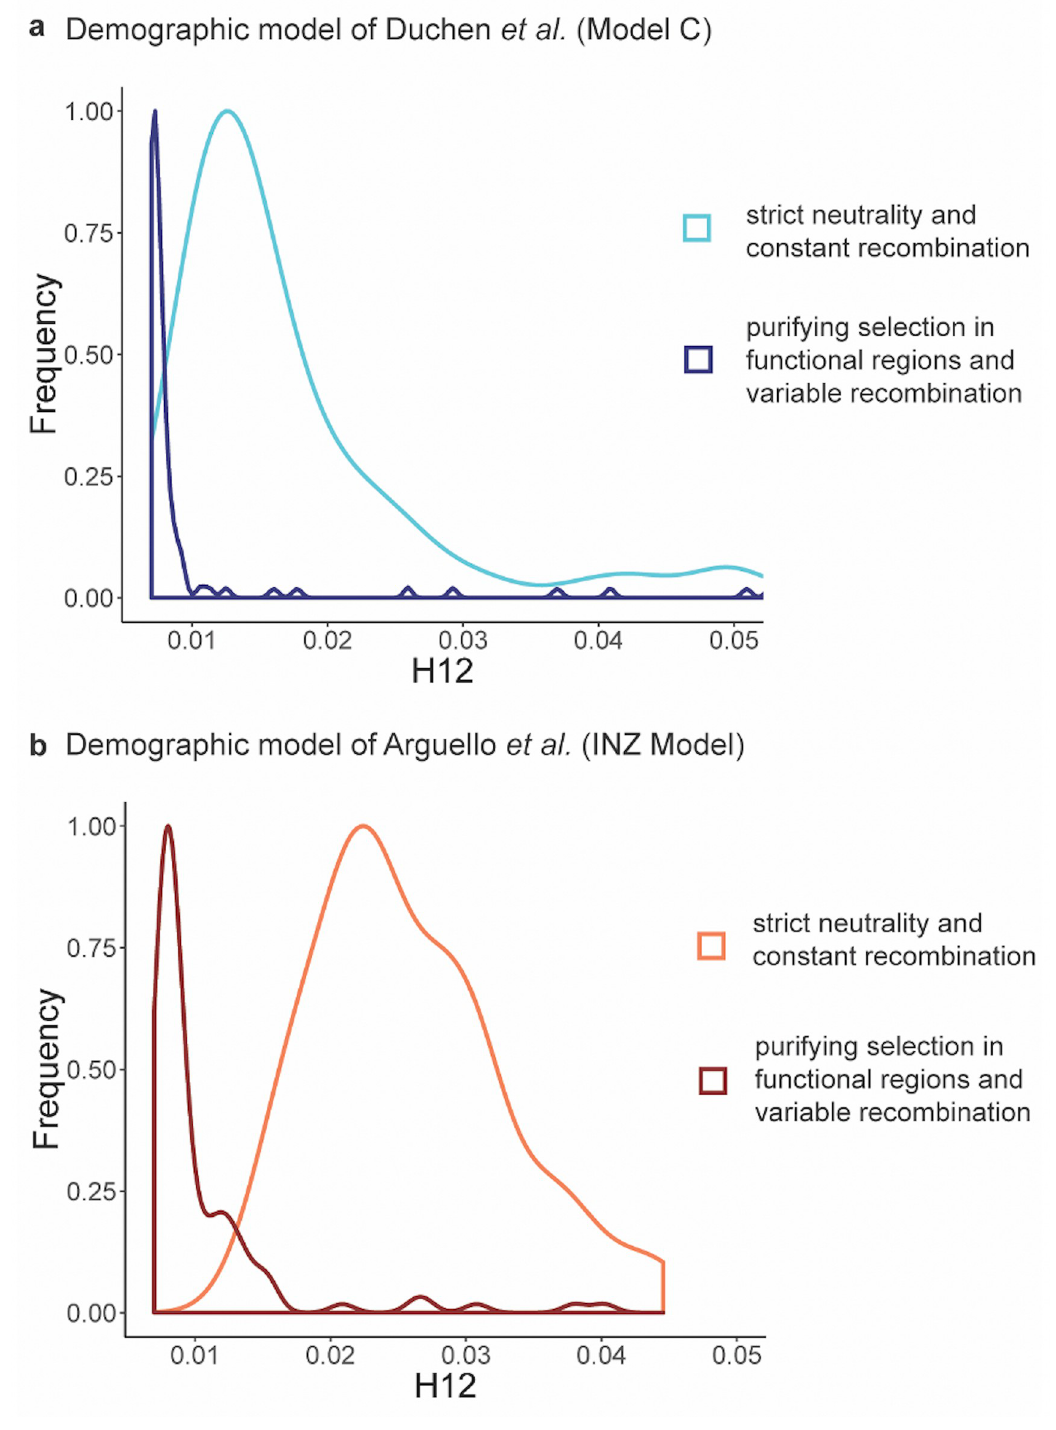
Fig 2. The distributions of the H12 statistic (from 100-kb regions, calculated in 401 SNP sliding windows following [2]) in the simulated Raleigh and Ithaca populations under the slightly modified best-fit demographic models inferred by (a) Duchen et al. 2013 [40] and (b) Arguello et al. 2019 [33]. For each demographic model, 2 scenarios are shown: strict neutrality with a constant recombination rate of 0.5 cM/Mb, as assumed by Garud, Messer, & Petrov [2] (100 replicates) and purifying selection in functional regions using the DFE of deleterious mutations inferred by Johri et al. 2020 [38], with variable recombination rates sampled from the D . melanogaster genome (100 replicates). The x-axes are truncated at 0.05 to show a clearer visualization of the means of the distributions. DFE, distribution of fitness